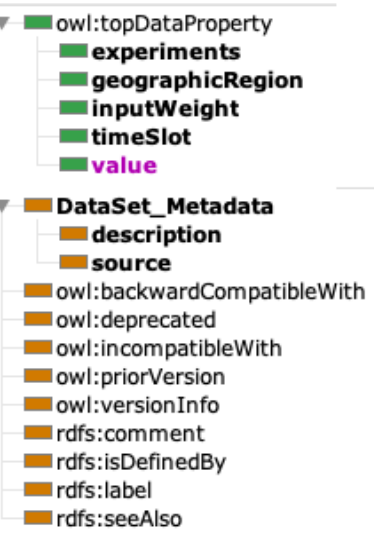
Figure 8. Attributes and Annotations in Protege